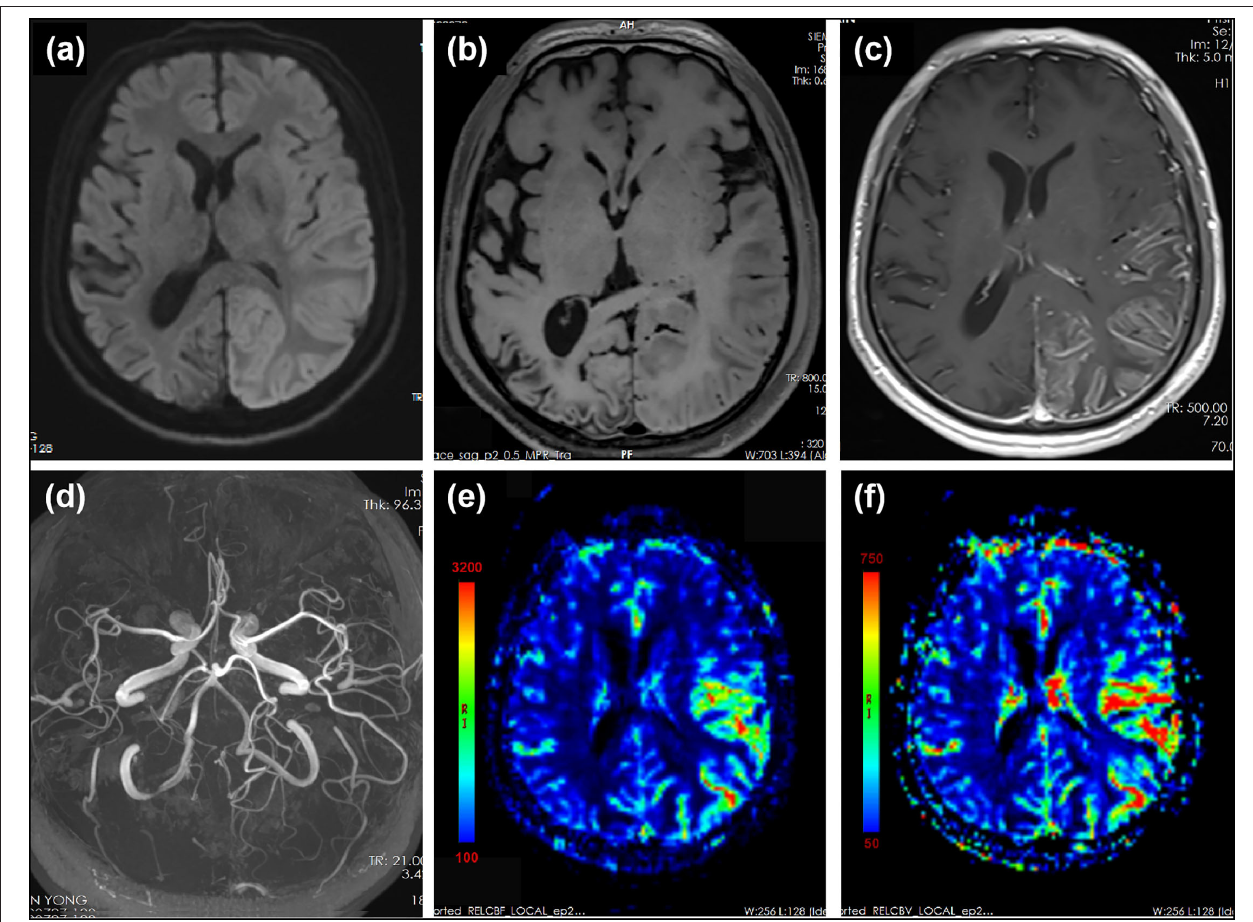
FIGURE 3 | MRI performed 15 days after the onset of the second prolonged attack. DWI showed extensive cortical edema with diffusion restriction involving the left hemisphere (a) . T1-weighted images showed slight hyperintensity in left temporal–occipital lobe and volume loss of right temporal–occipital lobe, suggestive of subacute and chronic stage of cortical necrosis, respectively (b) . Gadolinium-enhanced T1-weighted images showed cortical enhancement in the left temporal–occipital lobe (c) . MRA showed dilation of left MCA and PCA (d) . PWI showed increased cerebral blood flow (CBF) (e) and cerebral blood volume (CBV) (f) in the left hemisphere. Region of interest (ROI) placed on the left temporal–parietal area showed a mean relative CBF value of 486.1 compared with that of 123.1 on the right temporal–parietal area. ROI placed on the left temporal–parietal area showed a mean relative CBV value of 533.1 compared with that of 129.8 on the right temporal–parietal